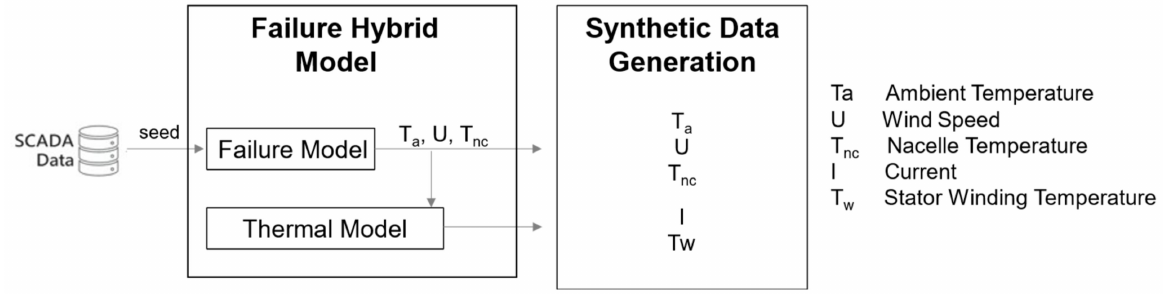
Figure 16. Multivariate synthetic failure pattern formed by the output of the data-driven stochastic model and the deterministic functions of the DT.